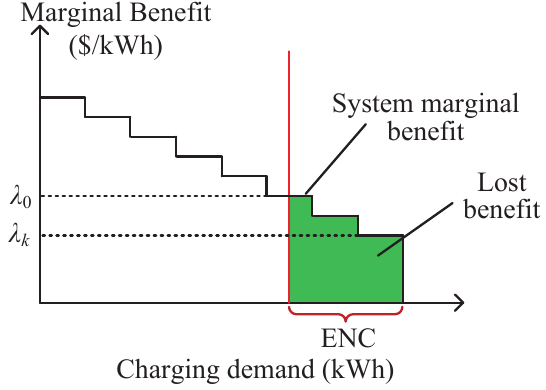
Figure 5. Demand curves ranking in descending